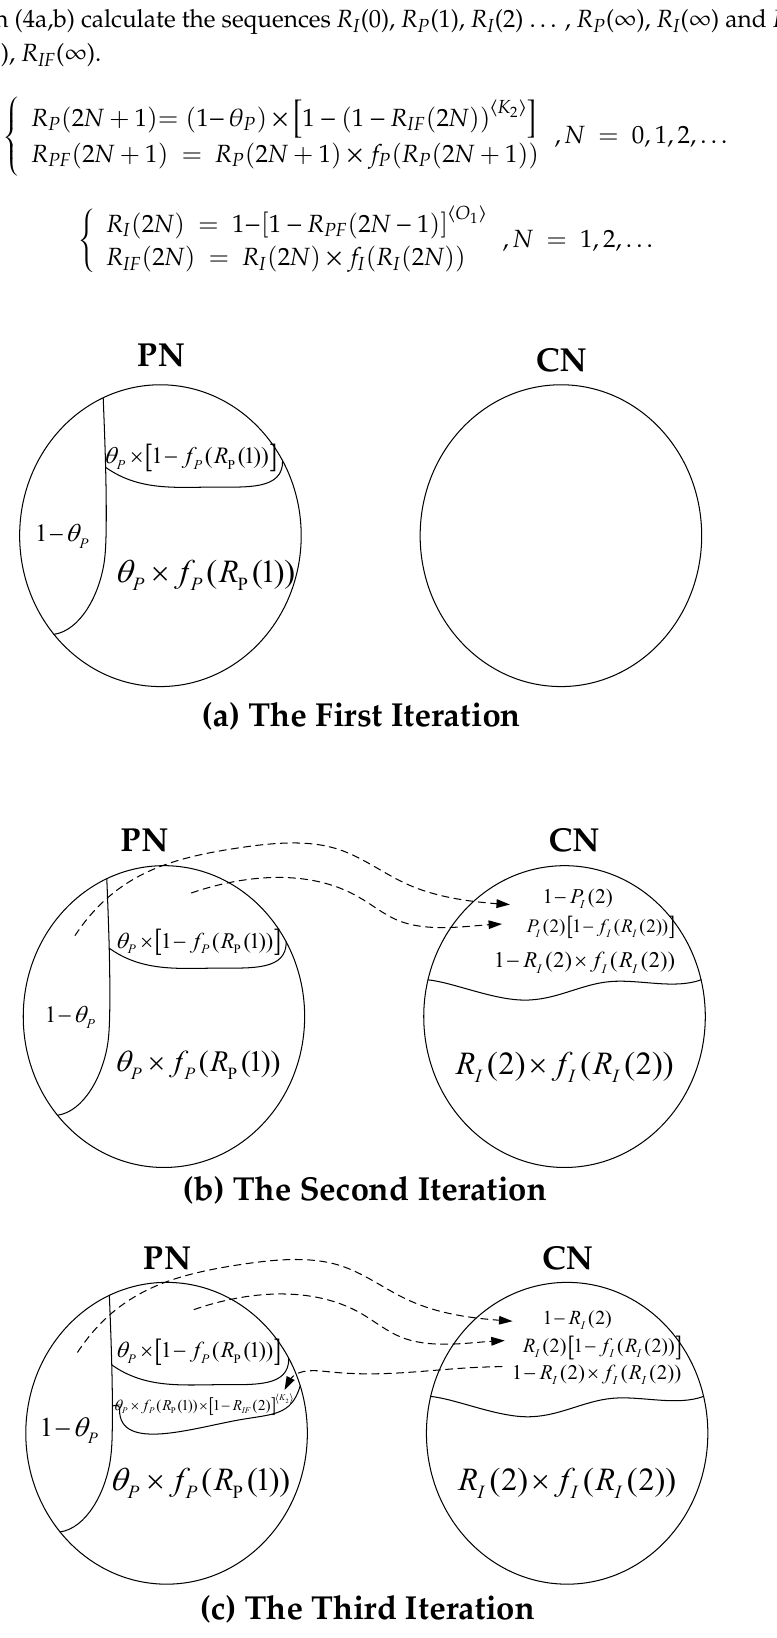
Figure 3. Venn diagram for computing R PF (N) / R IF (N) in the first three iterations.